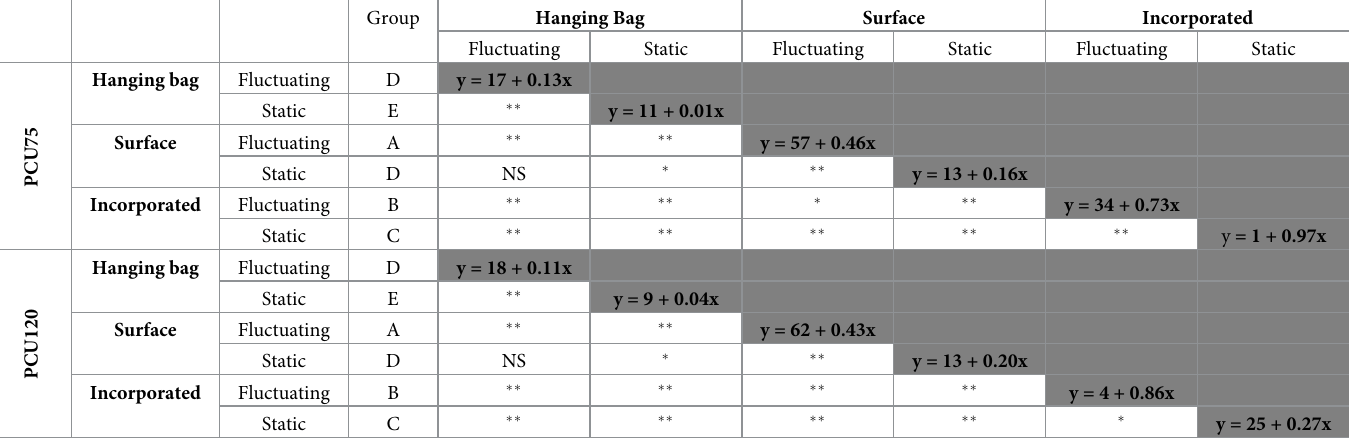
Table 2. Experiment 2 comparison of slopes of linear regression models used to model N release as a function of time for each fertilizer type and treatment combination.